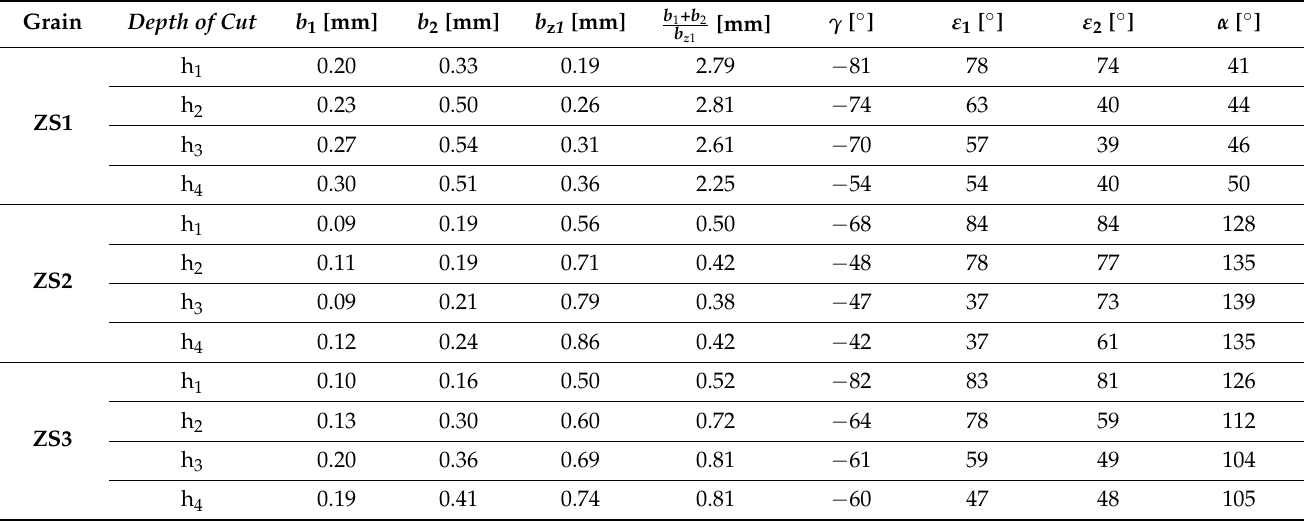
Table 2. Geometric parameters of tested abrasive